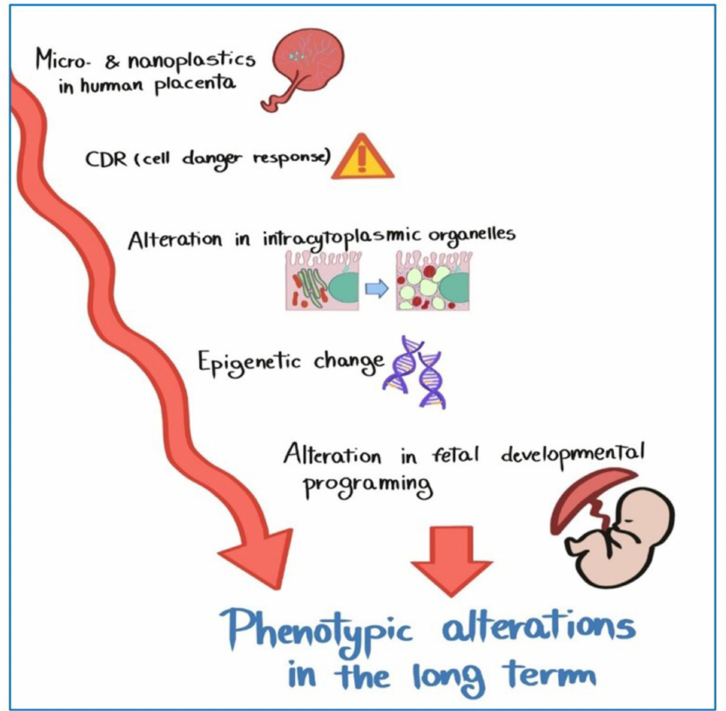
Figure 8. Hypotetical mechanism by which MPs could lead epigenetic changes that determine fetal phenotypic alterations in the